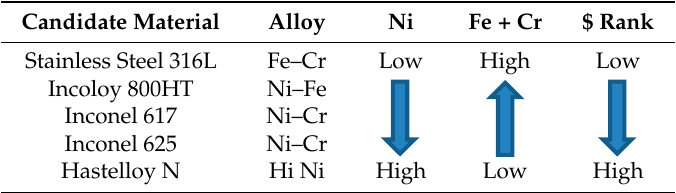
Table 1. TES vessel material candidates.